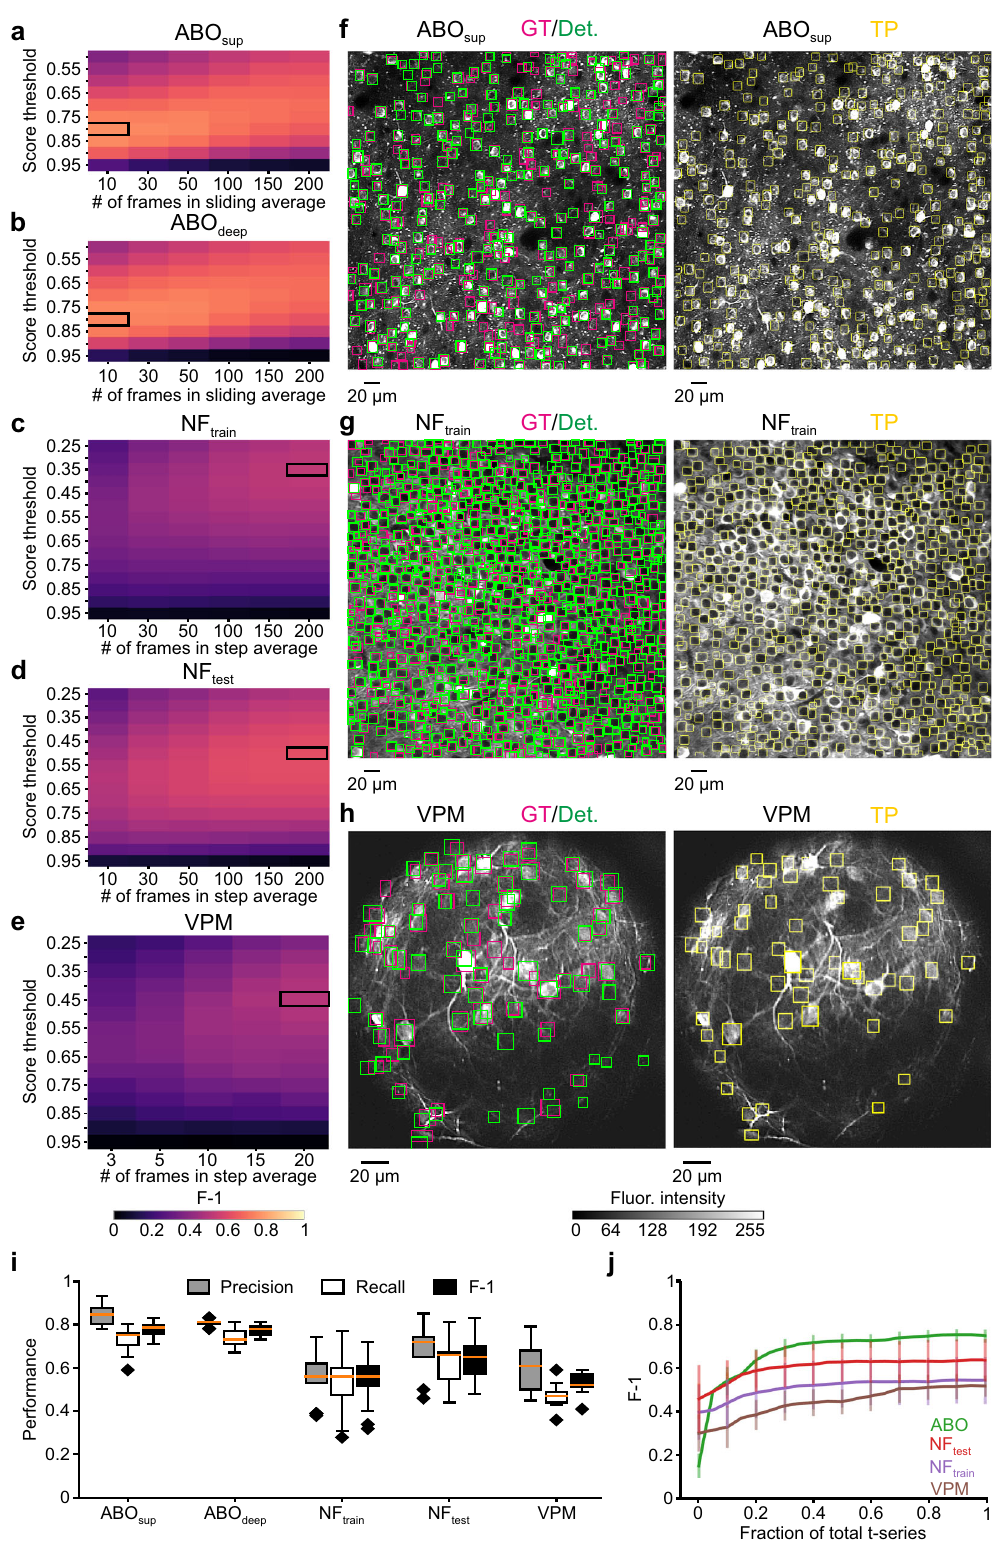
to the of fl ine detection obtained in the fi rst step described